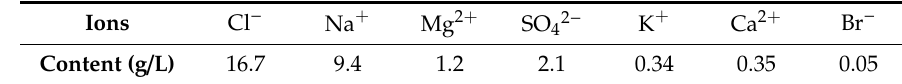
Table 3. Ions in the